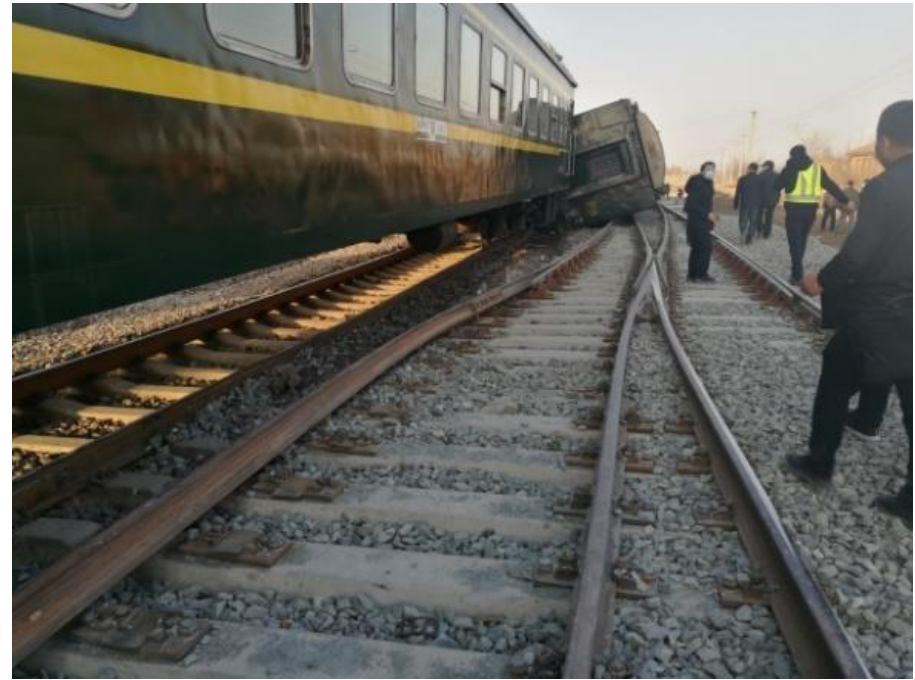
Figure 1. Vehicle derailment accident in the turnout area.